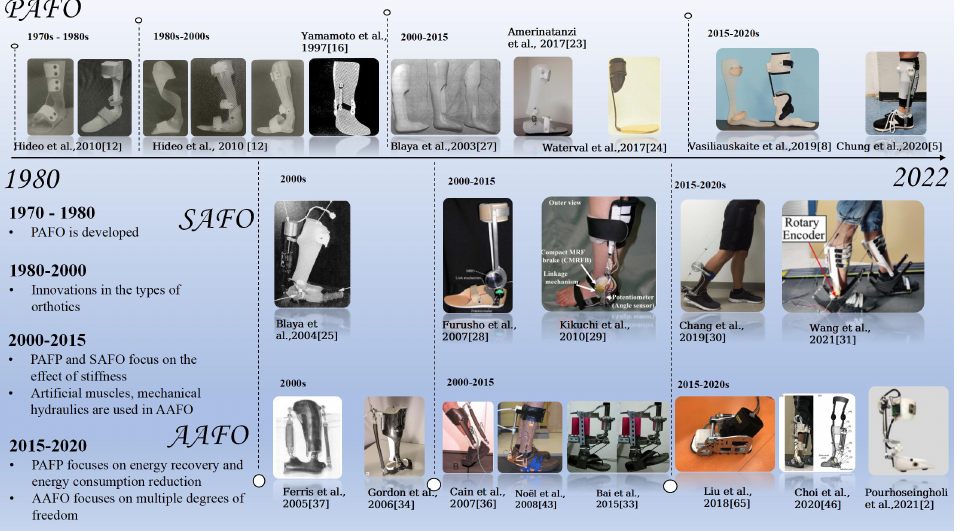
Figure 2. Classification and development trends of AFOs.